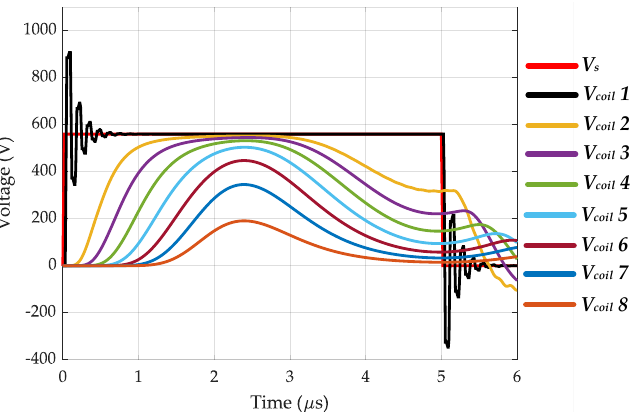
Figure 19. Coil-to-core voltages of different coils when a single-phase model is implemented and is excited by a 560 V PWM voltage with t r = 20 ns and the neutral point is grounded.